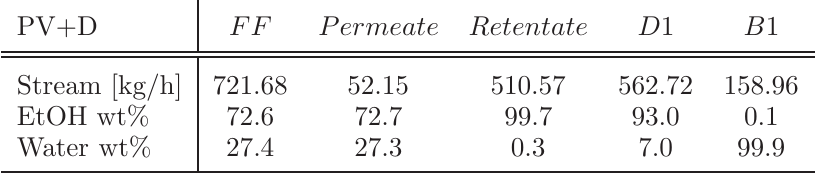
Fig. 7 Distillation followed with pervaporation (D+PV). Table 5 Technological streams of adiabatic pervaporation,